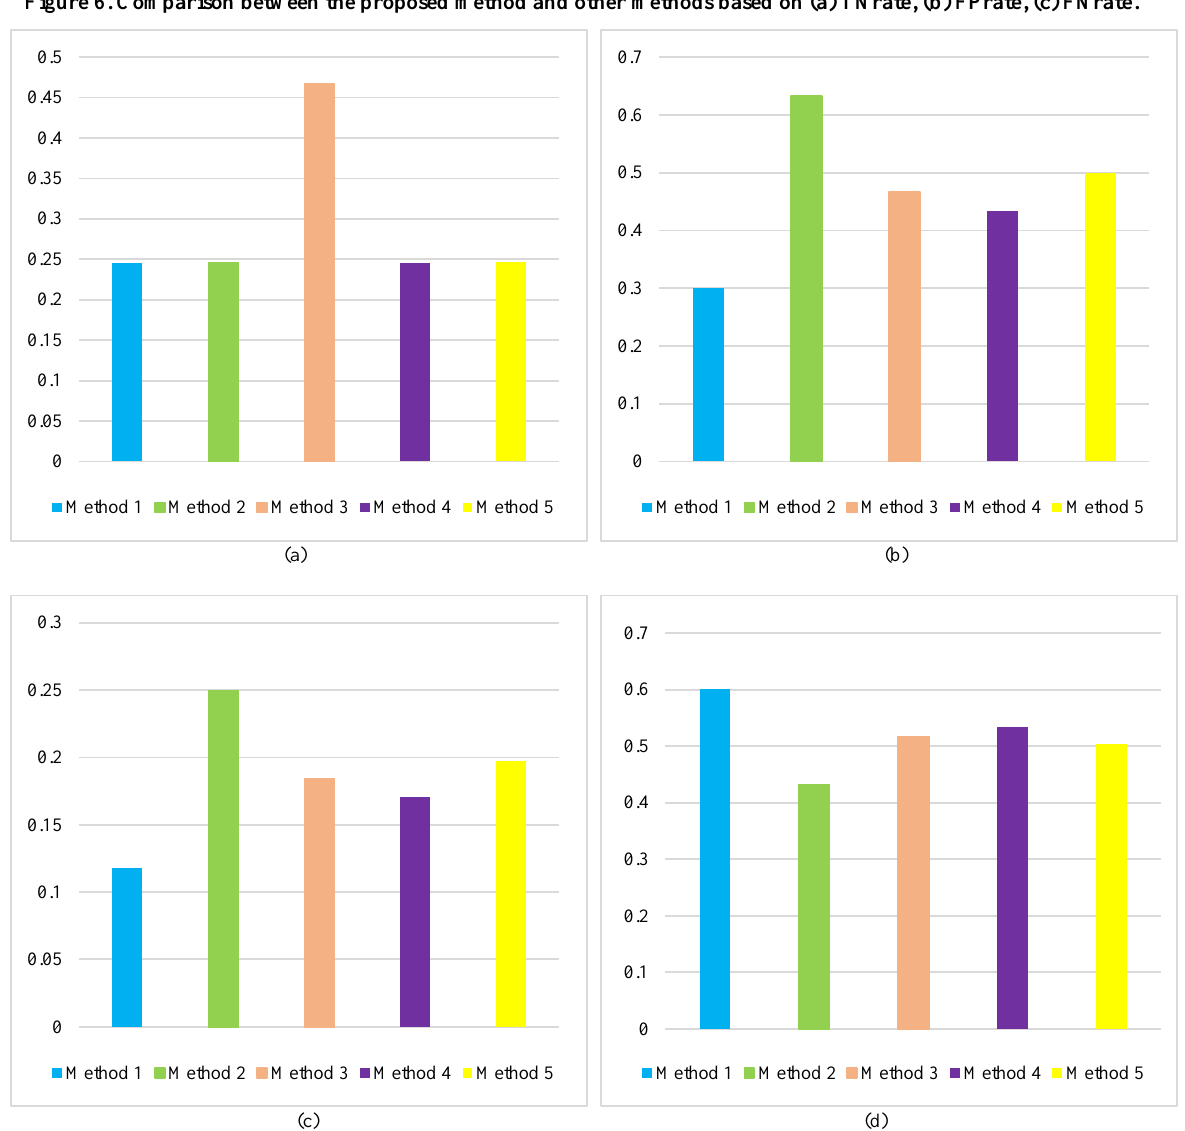
Figure 6. Comparison between the proposed method and other methods based on (a) TNrate, (b) FPrate, (c) FNrate.